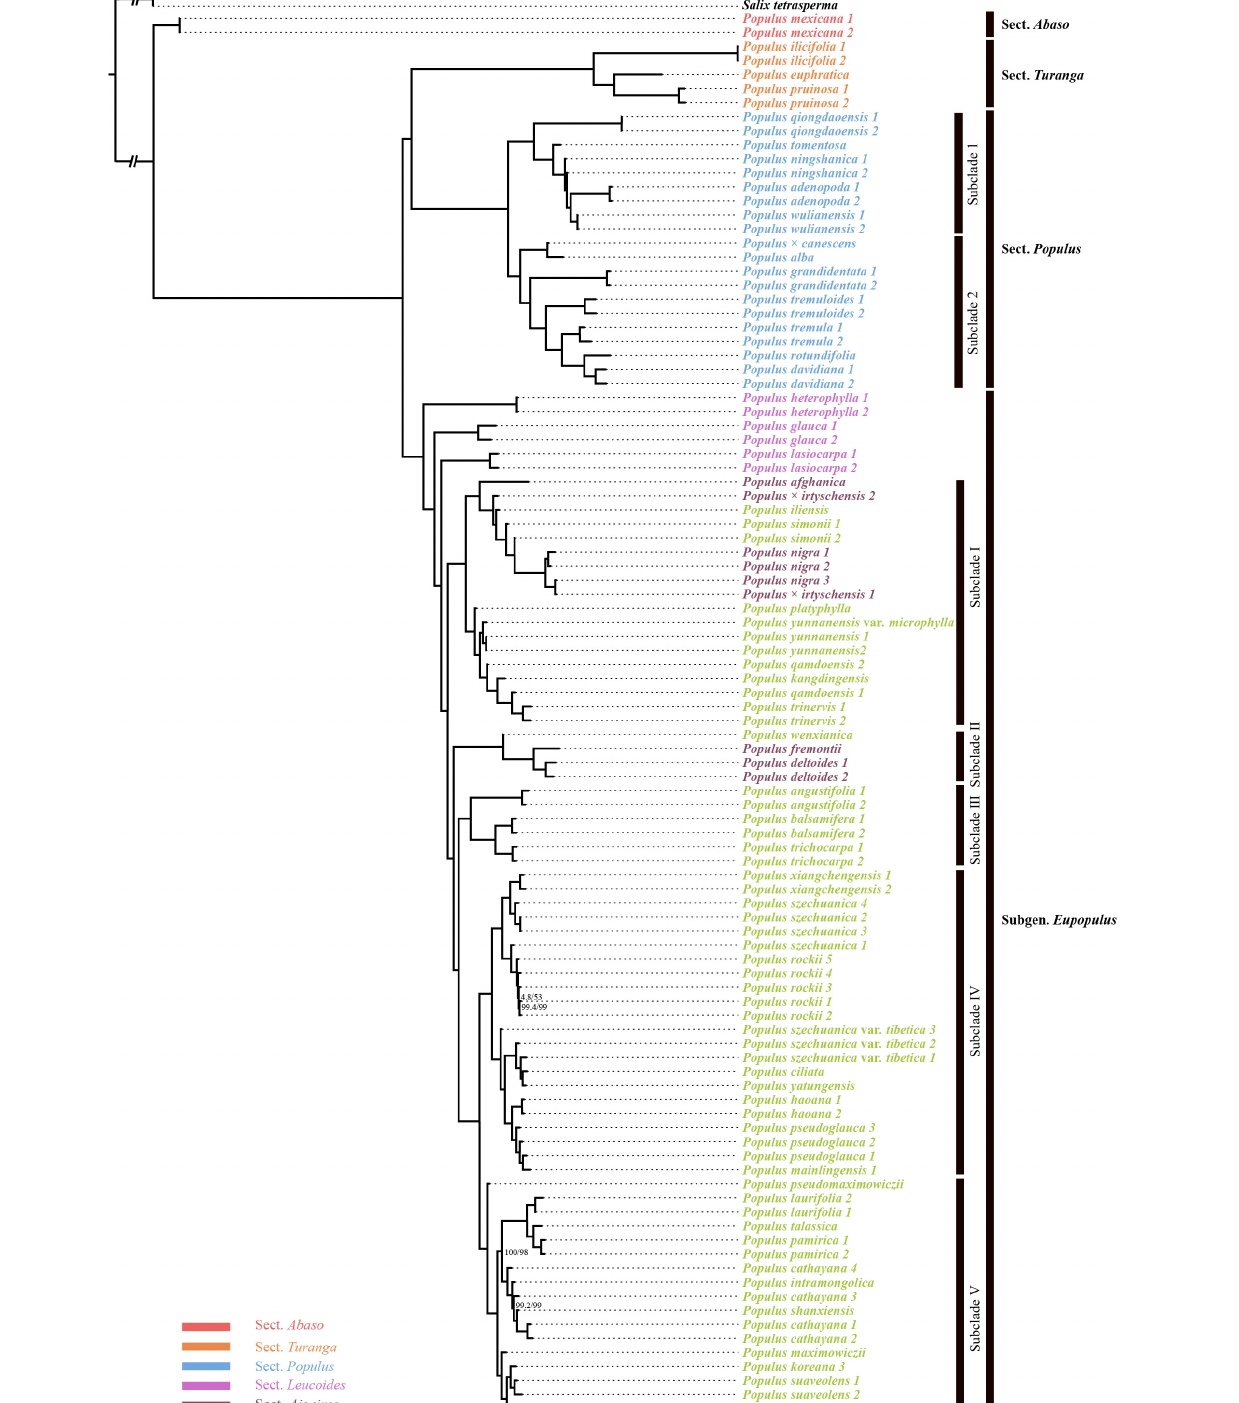
Frontiers in Plant Science |